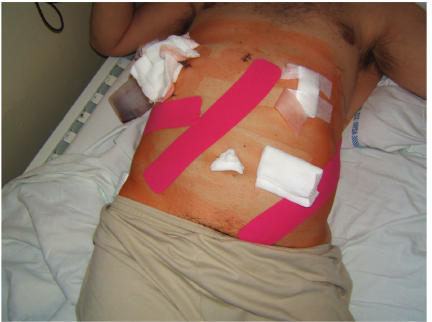
Figure 1: KT application on abdominal muscles and liver fascia.